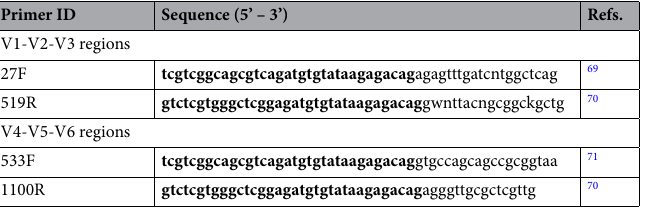
Table 4. Universal primers used for 16S rRNA amplification. Nextera adaptor sequences in